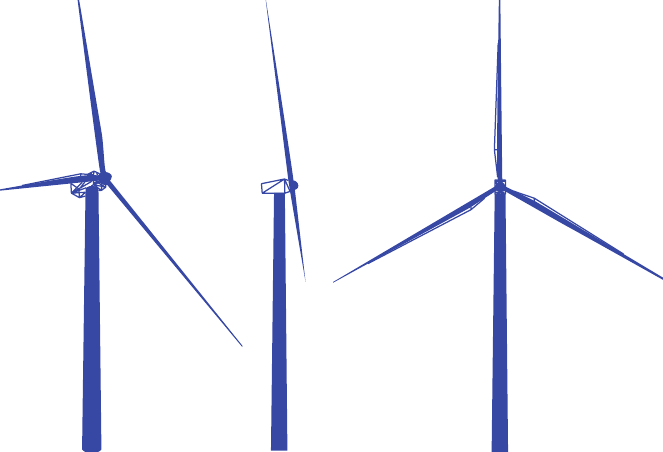
Figure 3: Facets-based representations of the whole wind